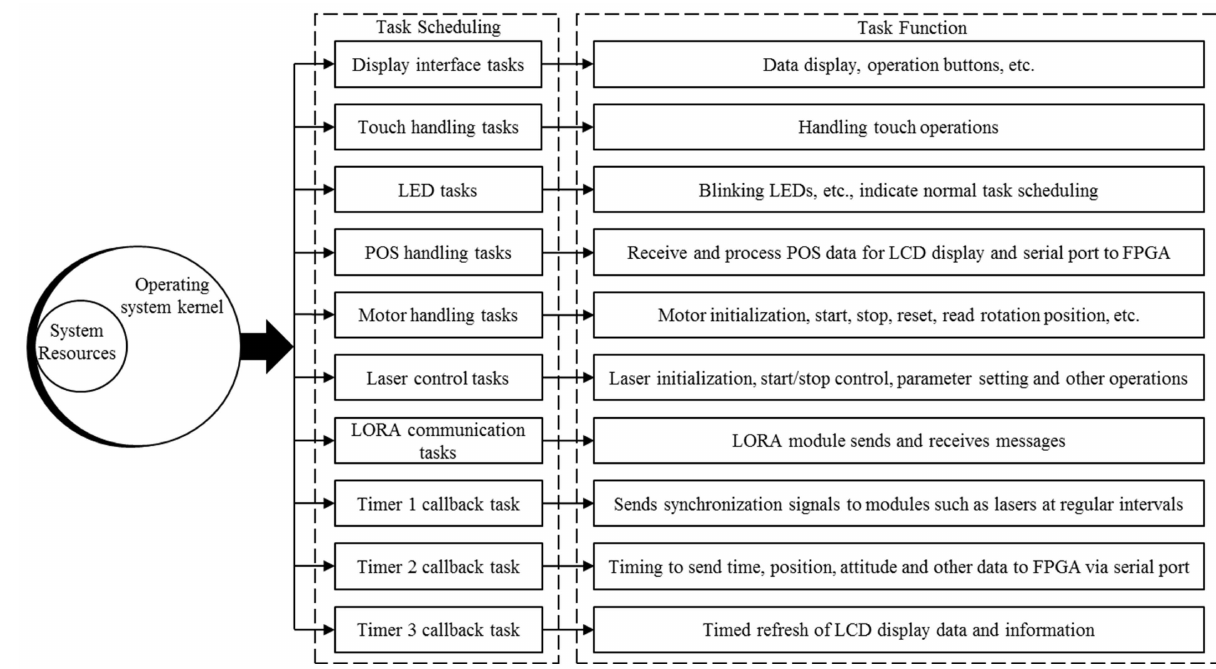
Figure 12. Main control part of the operating system task scheduling flowchart.